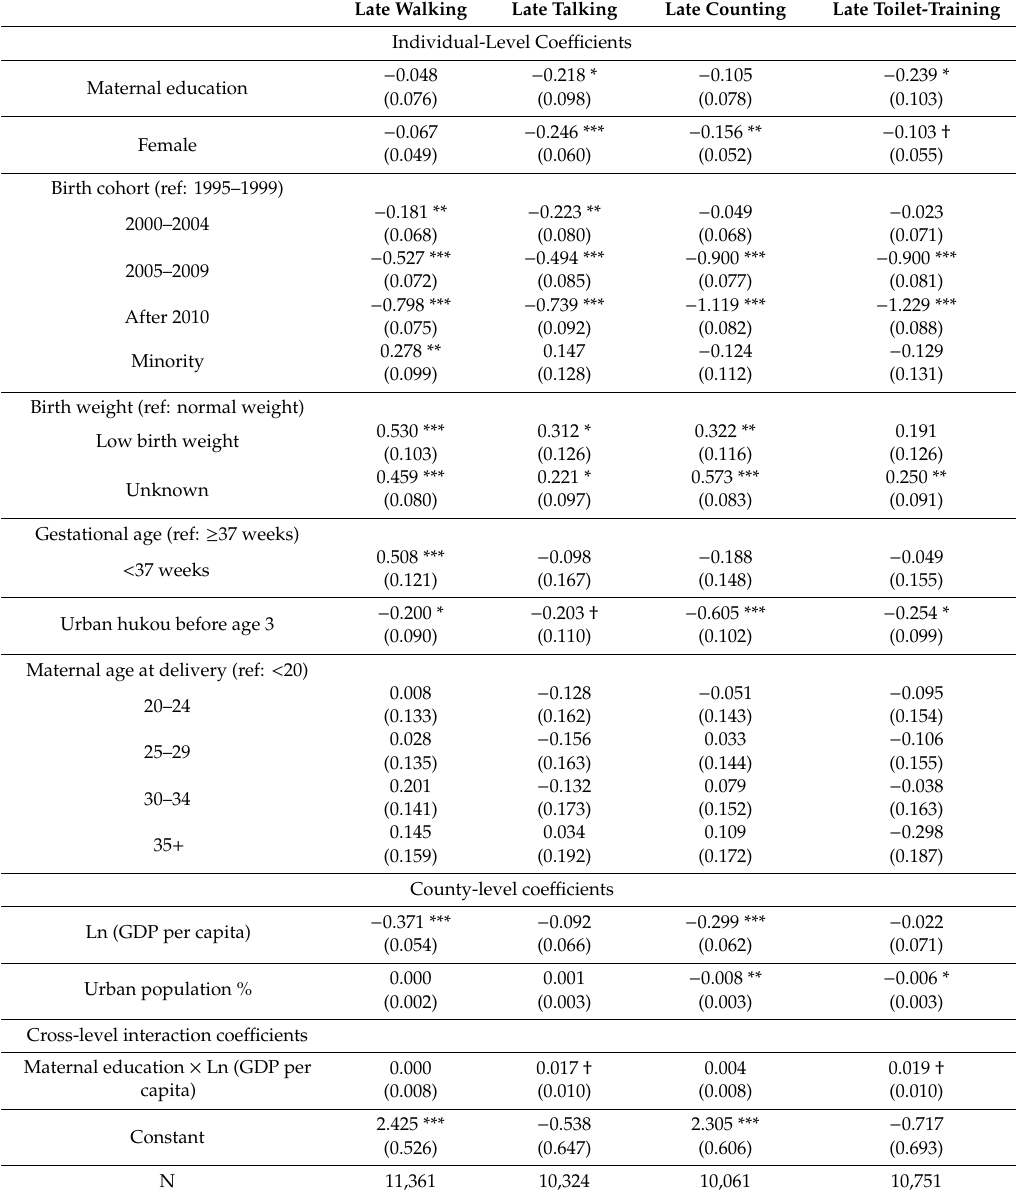
Table 3. Two-level Logistic Regression Models of Early Developmental Milestones on Individual and County-level